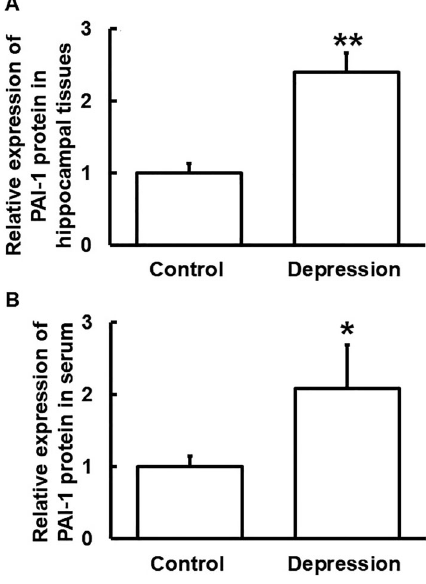
Figure 3. Relative expression of plasminogen activator inhibitor-1 (PAI-1) protein in ( A ) hippocampal tissues and ( B ) serum from mice in the control and depression groups. Expression of protein in hippocampal tissues and serum were determined by Western blotting and ELISA, respectively. Data are reported as means ± SD. *P o 0.05 and **P o 0.01 compared with control ( t